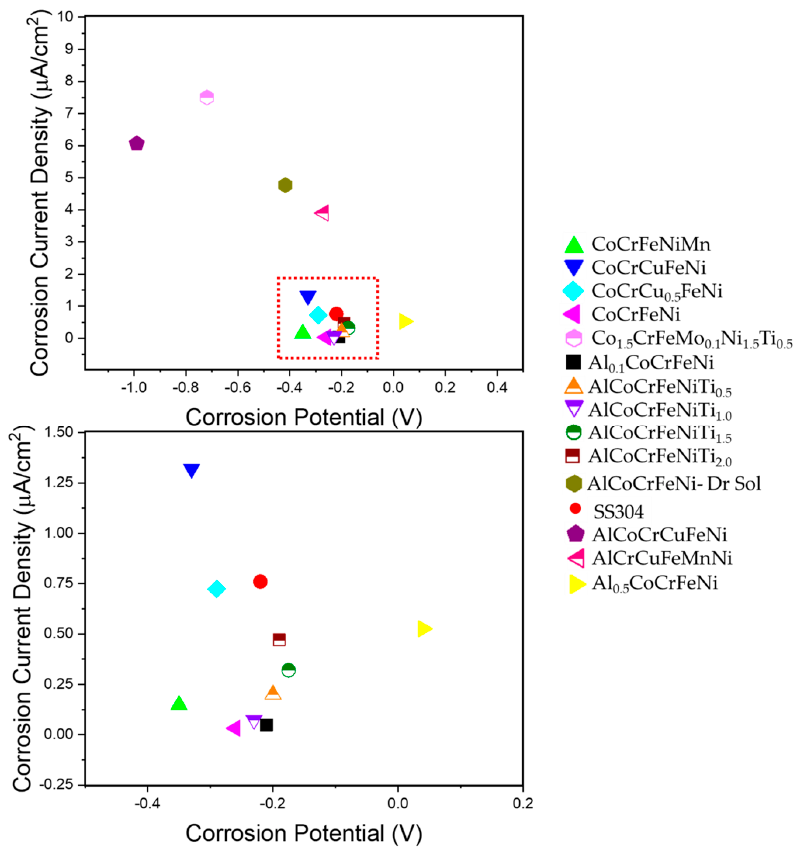
Figure 17. Corrosion current density versus corrosion potential for CCAs/high entropy alloy (HEAs) in 3.5 wt% NaCl solution [18,28,29,31,32,34,51,63–65].